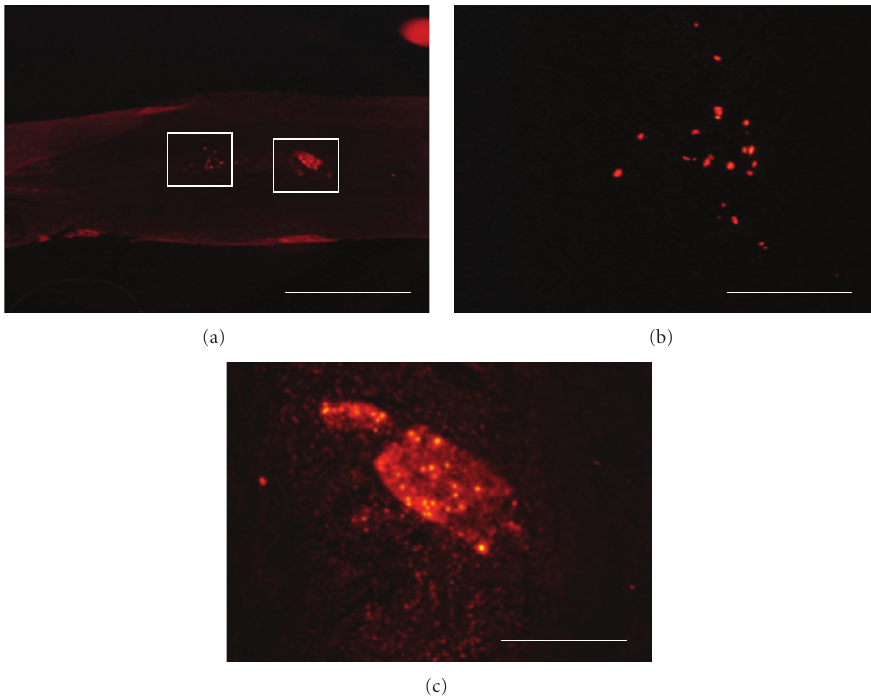
Figure 3: Localization of transplanted BrdU-labeled neurospheres in the bridged nerve at 8 days after lesion, by postmortem immunohistochemistry. BrdU immunoreactivity is revealed by red Alexa-594 fluorescence on longitudinal postfixed graft sections at low (a) and high (b, c) magnifications. Enlarged fields (b, c) are localized as white forms in (a). Transplanted neurosphere cells are found either sparsed (b) or clustered (c) inside the venous bridge. Scale bars: 0.5 mm (a), 100 μ m (b, c).